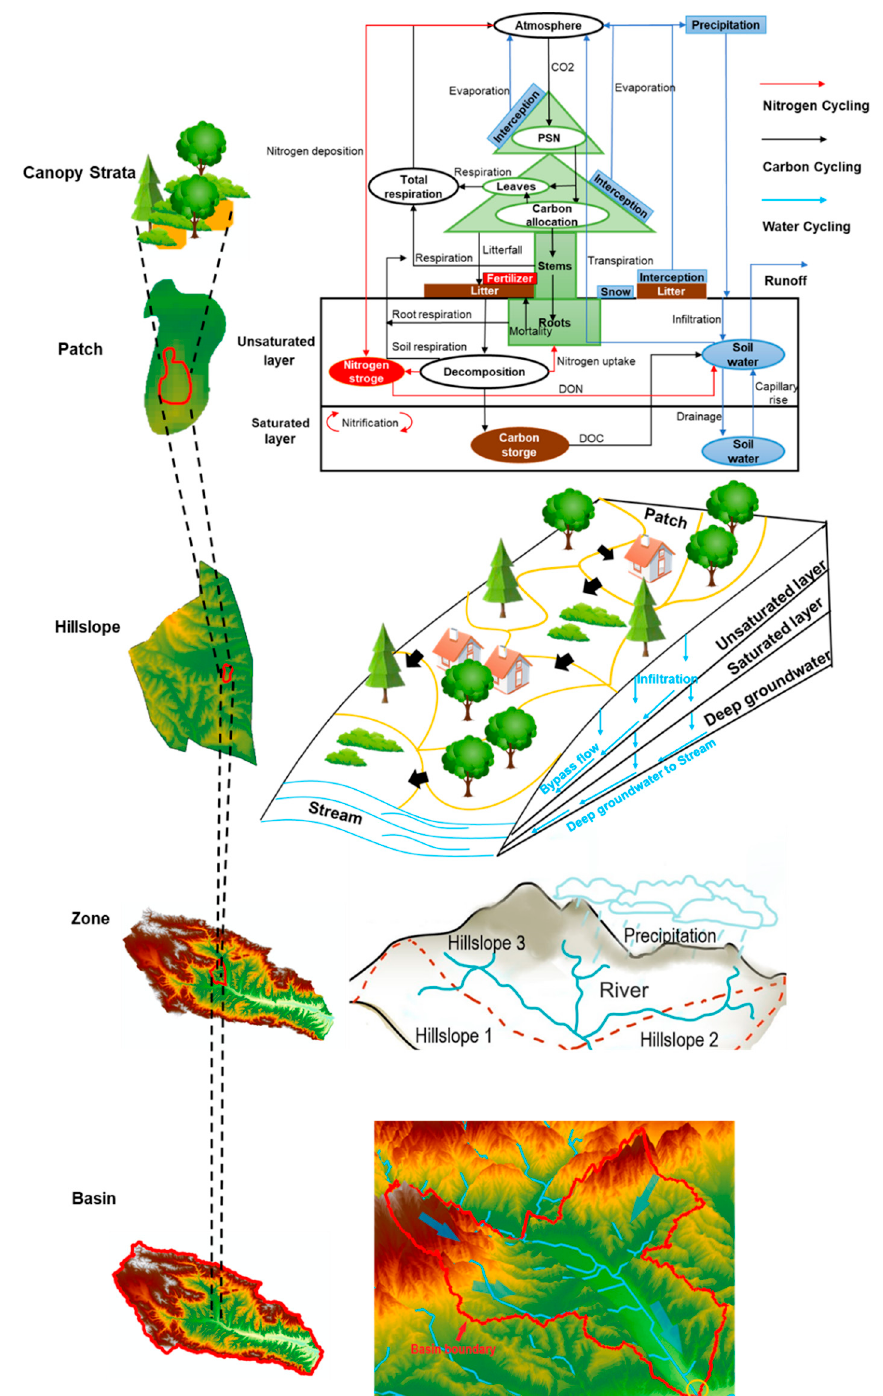
Figure 2. The hierarchical structure of RHESSys (Edited based on [15,16]).